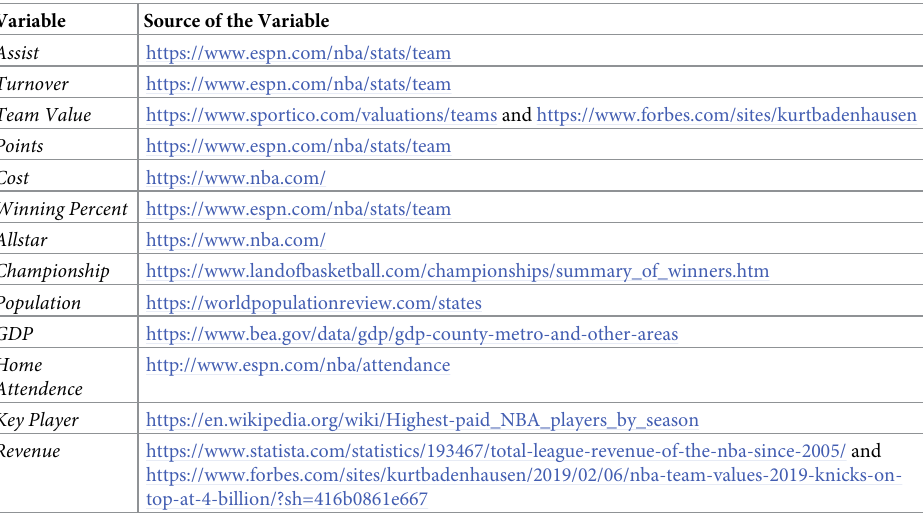
Table 2. The list of the data